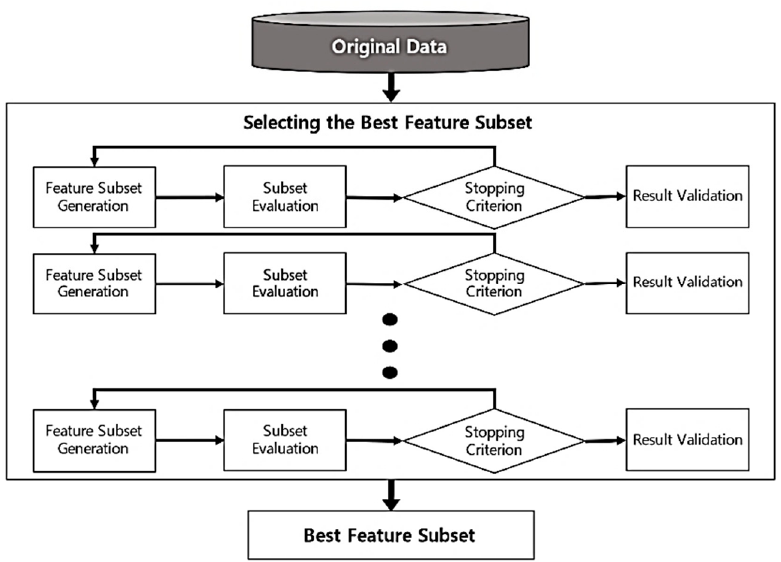
Figure 4. Overall schematic of the feature selection algorithm.